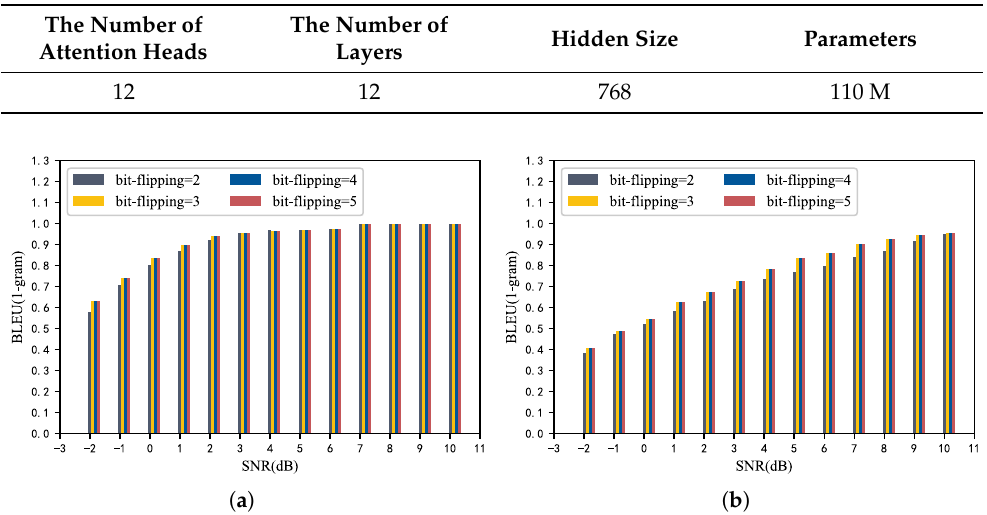
Table 1. Parameters of the used BERT model.